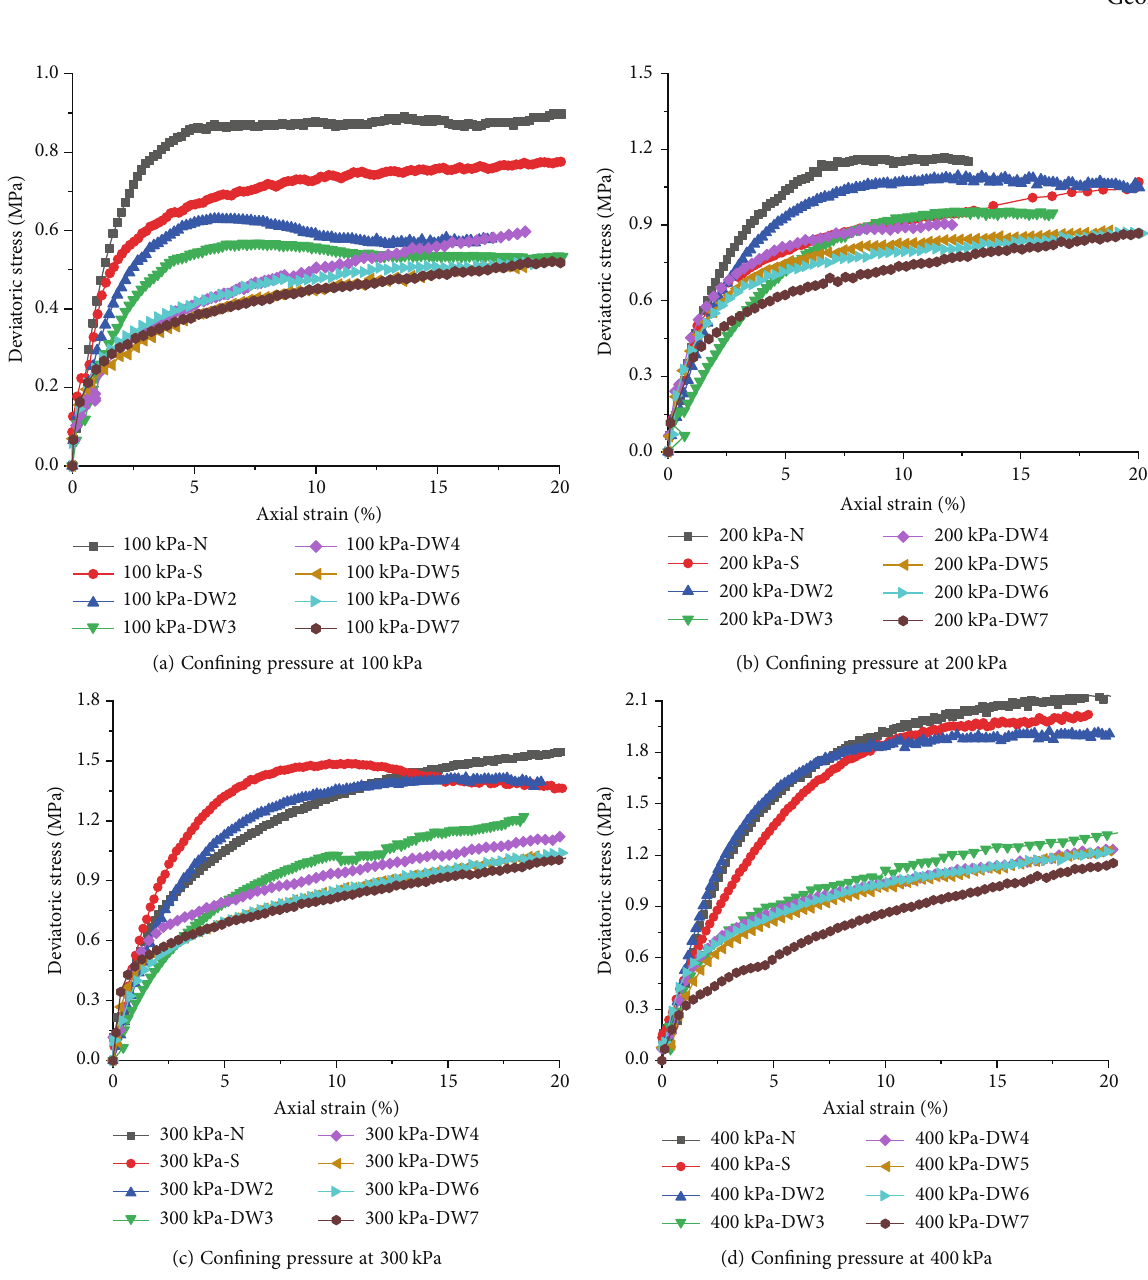
Figure 7: Stress – strain curves under drying – wetting cycles for various con fi ning